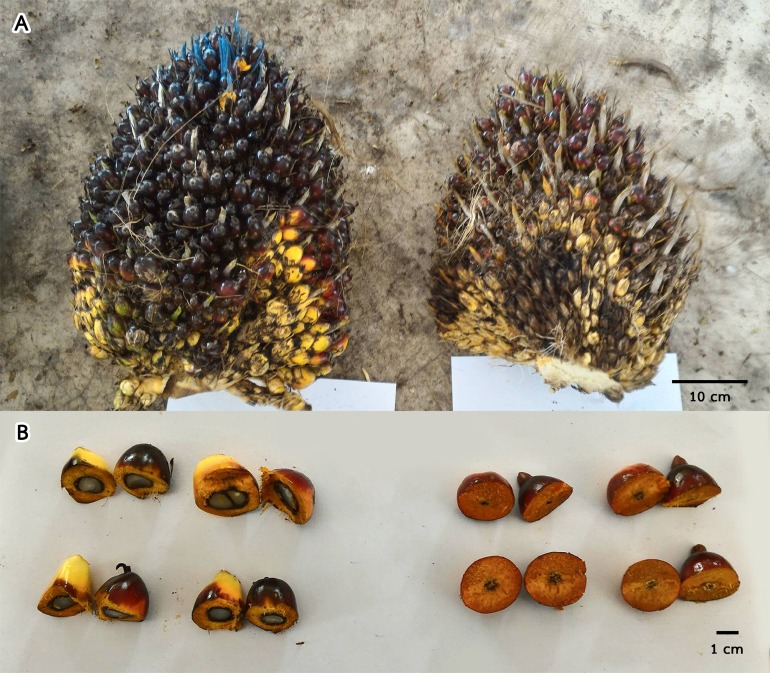
A comparison of oil palm bunches (A) and cross sections of fruits (B) between inflo.1C control fruits (left) and inflo.1T treated fruits (right) showing that the auxin treated fruits displayed 100% parthenocarpy.cm = size indicator in centimeter.